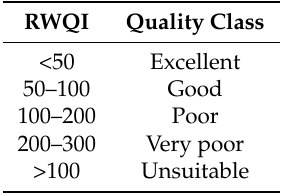
Table A4. The RWQI